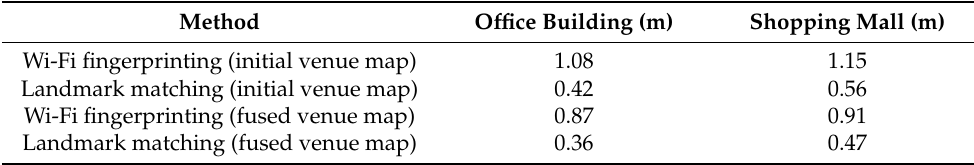
Table 2. The average localization error comparison of the office building and shopping mall